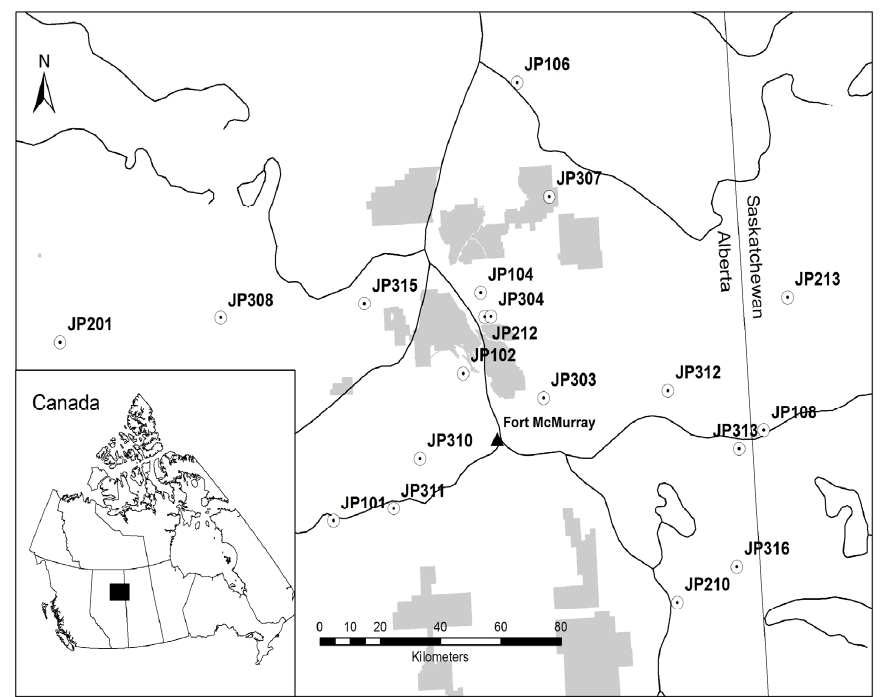
Figure 1. Map of study site location in northeastern Alberta, Canada, showing the 19 sampling sites where foliage samples were collected in 2011. The grey shaded areas represent active mining operations as of 2013. Main operations are centered near JP212 and JP102.